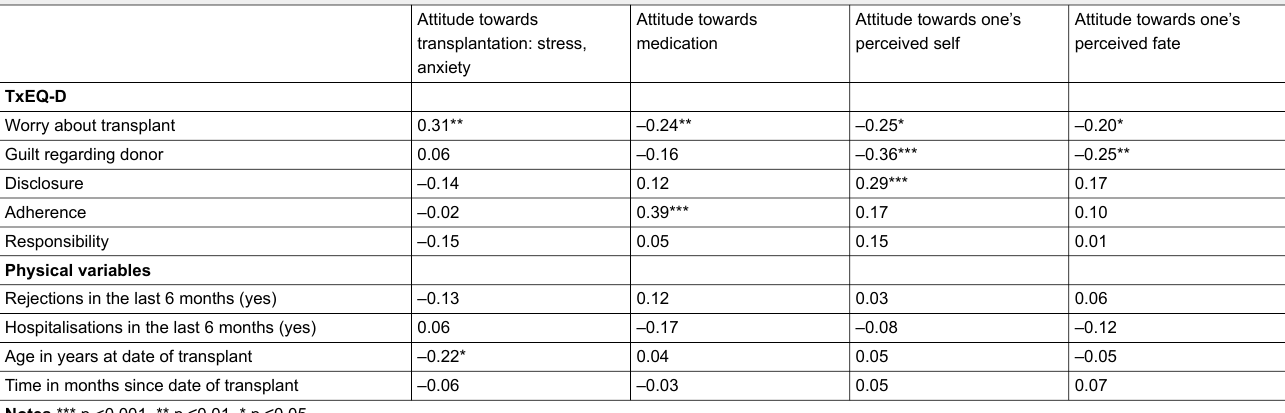
Table 4b: Correlations between the ‘Attitudes towards Transplantation’ Scales (ATTS) and the patient’s emotional response to the transplantation (Transplant Effects Questionnaire, TxEQ-D) as well as the patient’s physical variables (rejection, hospitalisation, age at the date of transplant, time since transplantation), n =